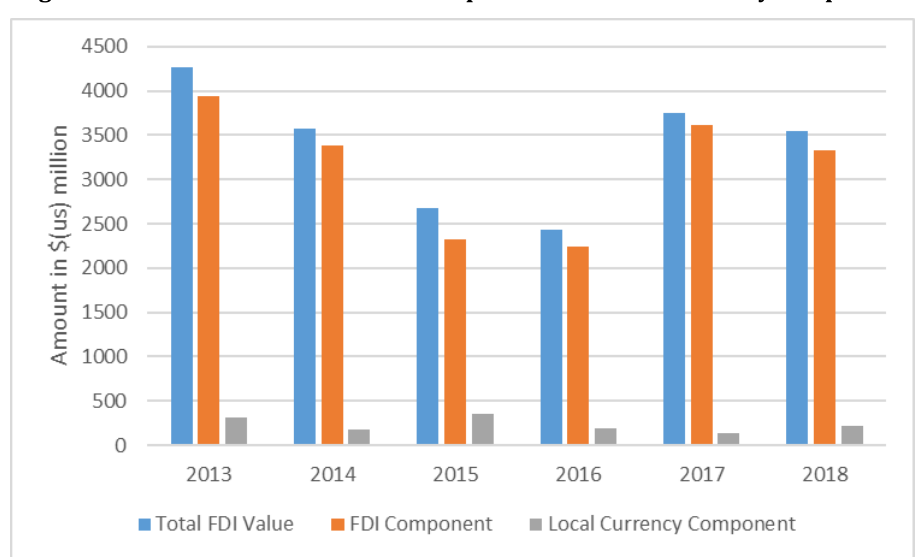
Figure 1: Total FDI value verse FDI component and Local currency